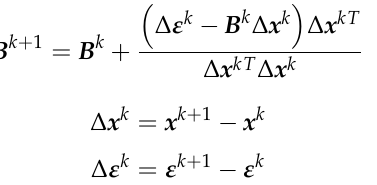
Table 4. Aerothermodynamic Generic Cycle Model (AGCM) independent and dependent parameters. i, j x i y state,j y demand,j 1 2 β 3 Fan map R-line 4 LPC map R-line 5 HPC map R-line C D ,080 A 080 C D ,080 A 080, design 6 HPC map N corr 7 8 HPT map PR C D ,180 A 180 C D ,180 A 180, design 9 LPT map PR